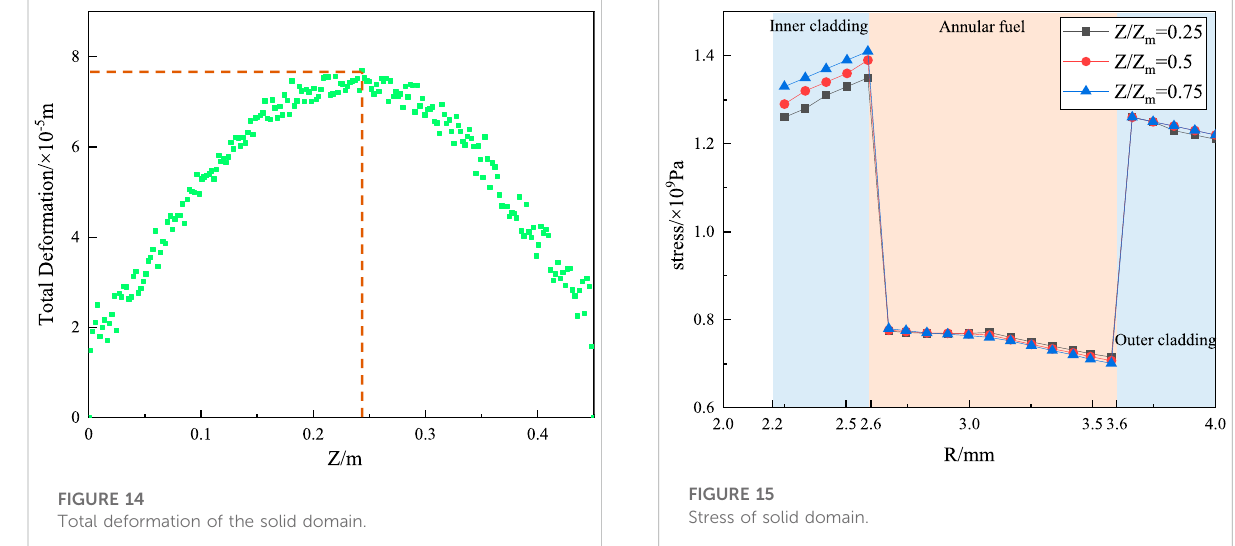
FIGURE 15 Stress of solid domain.